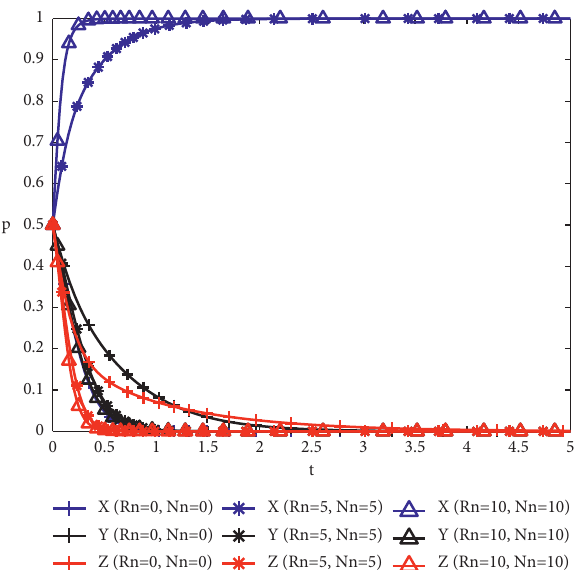
Figure 9: Evolution path under different positive and negative effects.